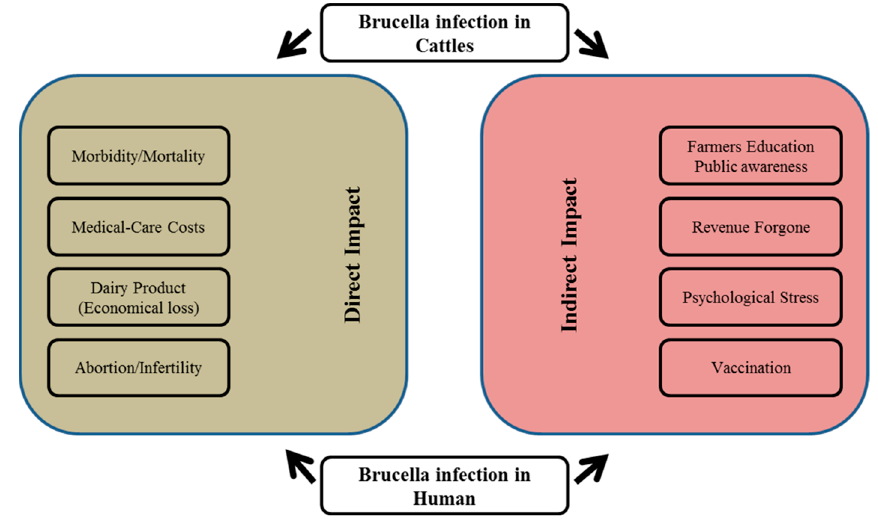
Figure1. Summarizing the impact of Brucella infection in humans as well in cattle. Figure 1. Summarizing the impact of Brucella infection in humans as well in